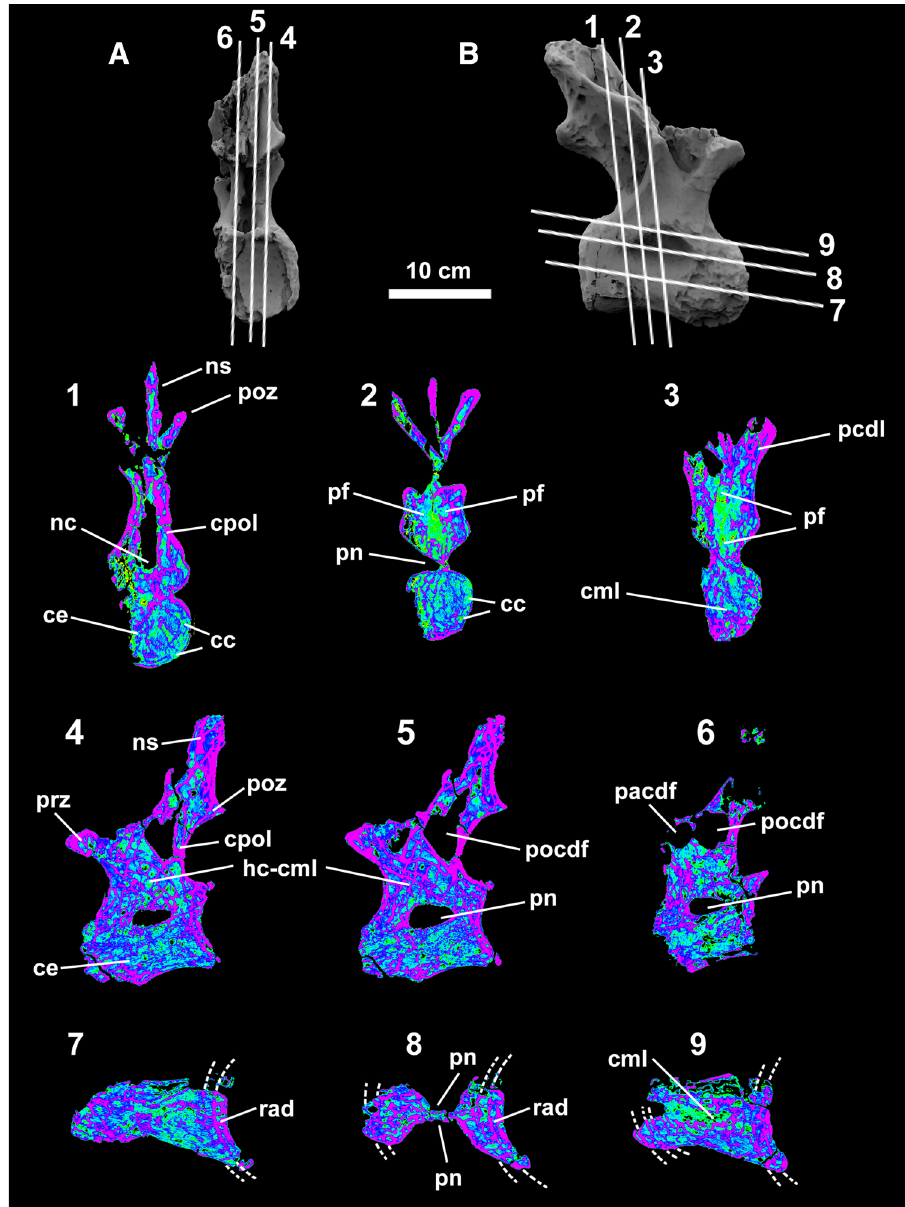
Figure 2. Dorsal vertebra internal structures of LPP-PV-0200. Reconstructed tomography model in distal ( A ) and right lateral ( B ) views illustrating subvertical tangential CT scan slices in false color (1–9). Images show that only a few structures had survived diagenesis which restricted the assessment of the internal architecture to limited spaces. Lighter blue and green indicate lower densities (e.g., pneumatic cavities). Purple and darker blue demonstrate denser structures (e.g., camellate bone). Dashed lines indicate internal plates of bone that sustain radial camellae. ce centrum, cc circumferential chambers, cml camellae, hc-cml ‘honeycomb’ camellae, ns neural spine, pf pneumatic foramen, pn pneumatopore, pacdf parapophyseal-centrodiapophyseal fossa, pocdf postzygapophyseal-centrodiapophyseal fossa, rad radial camellae. Computed tomography data processed with 3D Slicer version 4.10. Figures were generated with Adobe Photoshop CC version 22.5.1